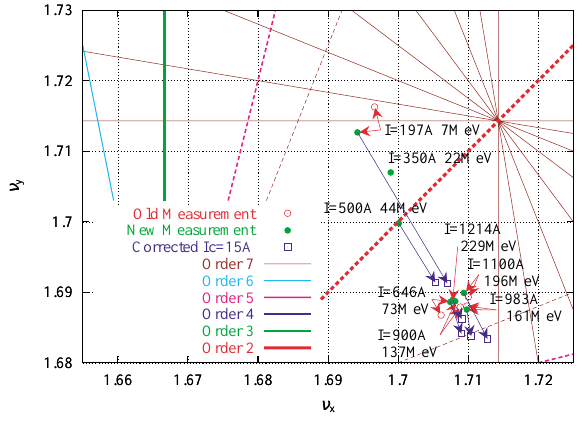
FIG. 15. (Color) Tune diagram from field